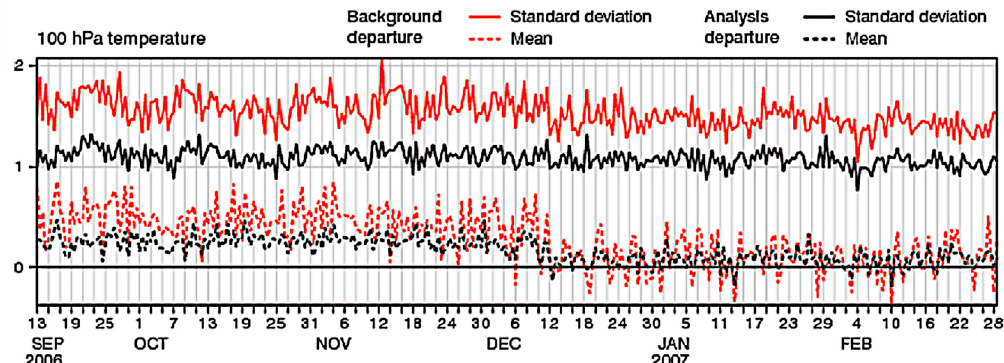
Figure 2. Time series of the mean and standard deviation of short-range forecast and analysis fitted to the radiosonde temperature measurements in the southern hemisphere, for the operational numerical weather prediction (NWP) system at the European Centre for Medium-Range Weather Forecasts (ECMWF) [37]. With the assimilation of COSMIC RO data operationally by the ECMWF since December 2006, there has been an apparent improvement in the short-range forecast and analysis.